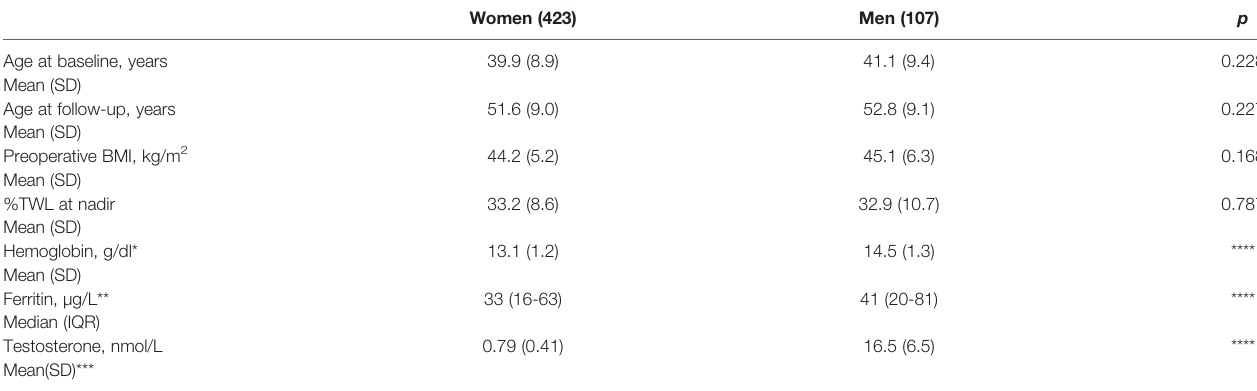
TABLE 1 | Patients ’